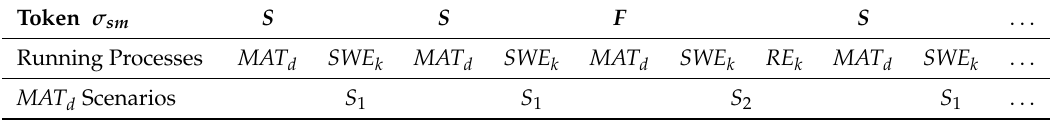
Table 6. A feasible LZMA system static sequential schedule. Token σ sm where S = Search and F = Flush. Token σ sm S S F S . . . Running Processes MAT d SWE k MAT d SWE k MAT d SWE k SWE k MAT d Scenarios S